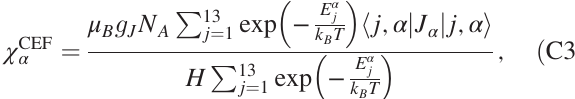
TABLE II. Fitted CEF energy levels and the corresponding CEF states under 0